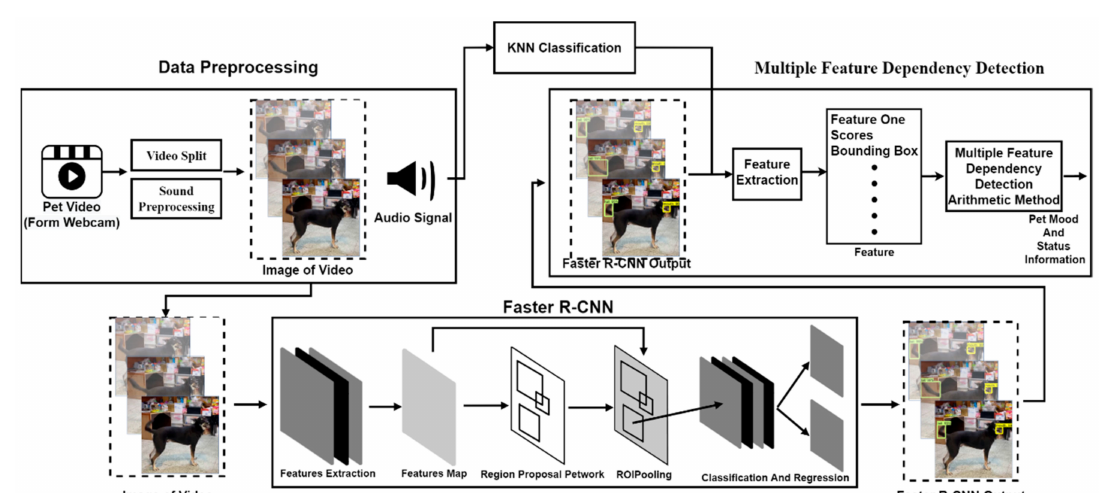
Figure 2. Identification network